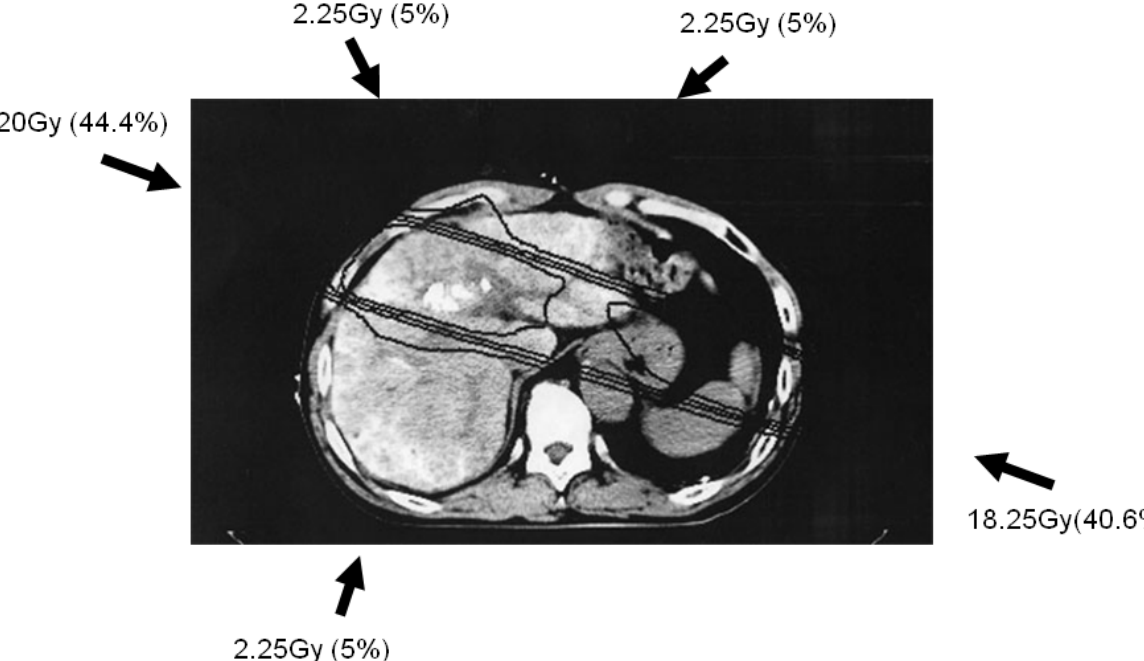
(PTV) included CTV with a 10-mm margin, accounting for respiratory-induced motion, penumbra covering, and variations in daily setup. Figure 1. Simulation planning of three-dimensional conformal radiotherapy. Five radiation beams (arrows) were set up to irradiate the clinical target volume (CTV), defined as main tumor and portal vein tumor thrombus. Doses of the high-dose beams were limited to 38.25 Gy/18 fractions/4 weeks; three additional low-dose beams of 6.75 Gy/18 fractions/4 weeks were required to elevate the dose to the CTV, resulting in a total dose of 45 Gy. The iso-dose distribution curves indicate 40, 30, 20, and 10 Gy, from innermost to outermost.